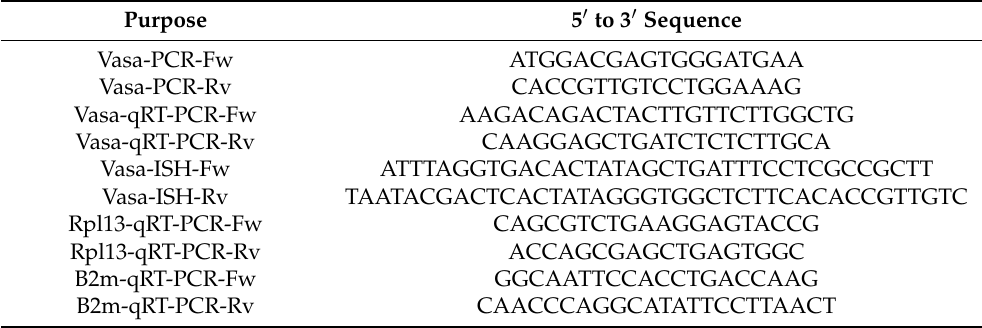
Table 1. Sequences of primers used in the